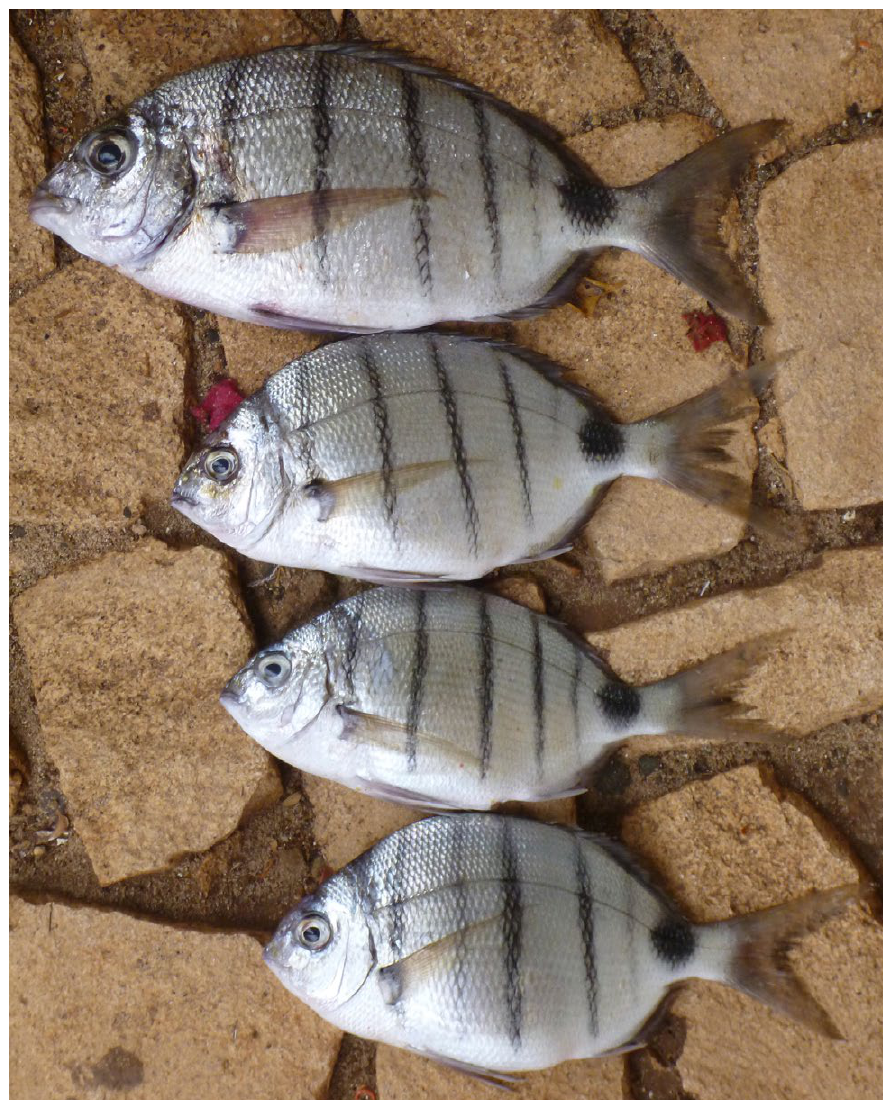
Fig. 10. – Diplodus lineatus , HUJ 20368, 4 spec (Upper to lower: 222, 176, 166, 162 mm SL), Boa Vista, Cape Verde Islands, 9 Sept. 2014. Lateral view; photograph of the fresh colouration taken a few hours after collection (Photograph: R.